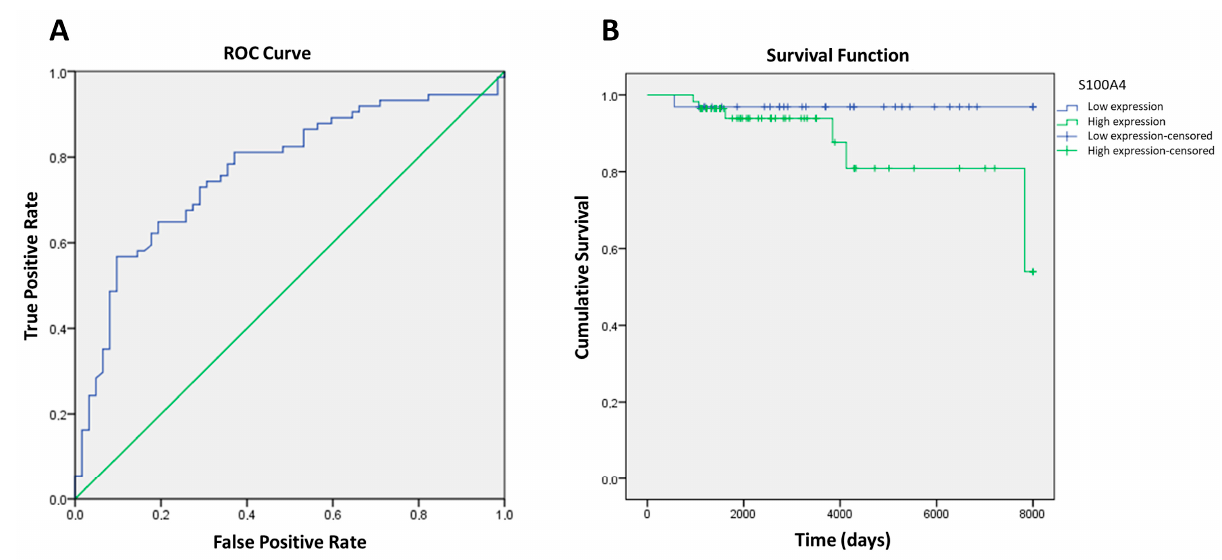
Figure 3. Characteristics of S100A4 as a biomarker in plasma. ( A ) ROC (Receiver operating character- istic) curves analysis in S100A4 ; ( B ) overall survival in days calculated to S100A4 optimal cut-point. Although all markers are statistically significant (see Table 1) S100A4 is the biomarker with the best performance, with an AUC value of 0.735 (95% CI = 0.668–0.803) and a specificity of 90.32%. Analysis of the other genes did not show a high discriminatory capacity (AUC < 0.70). However, the different combinations of present genes analyzed in blood provide slightly additional benefits with AUC levels > 0.74 (details in Table 2). Table 2. ROC parameters for diagnosis of PC patients in serum biomarkers alone and